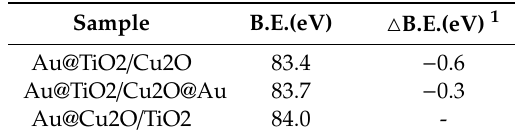
Table 3. Au 4f XPS analyses of the